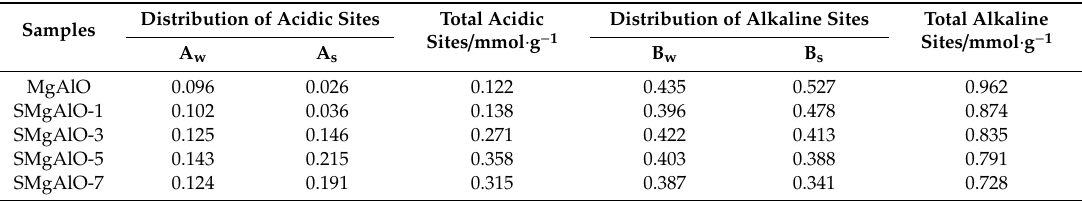
Figure 4. NH 3 -TPD curves of MgAlO and SMgAlO-y series ( a ); and CO 2 -TPD curves of MgAlO and SMgAlO-y series ( b ). Table 2. Acidity, and alkalinity of MgAlO and SMgAlO-y series.